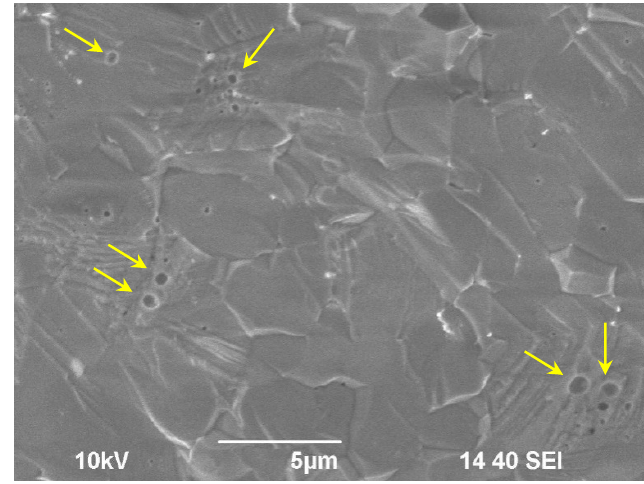
Figure 1. SEM image of a fracture of a sintered ceramic sample. The ceramics were identified to be single phase materials with a garnet structure (sp. gr. Ia3d, ICDD Card No. 08-0178). There were no changes in the phase composition during leaching (Figure 2).